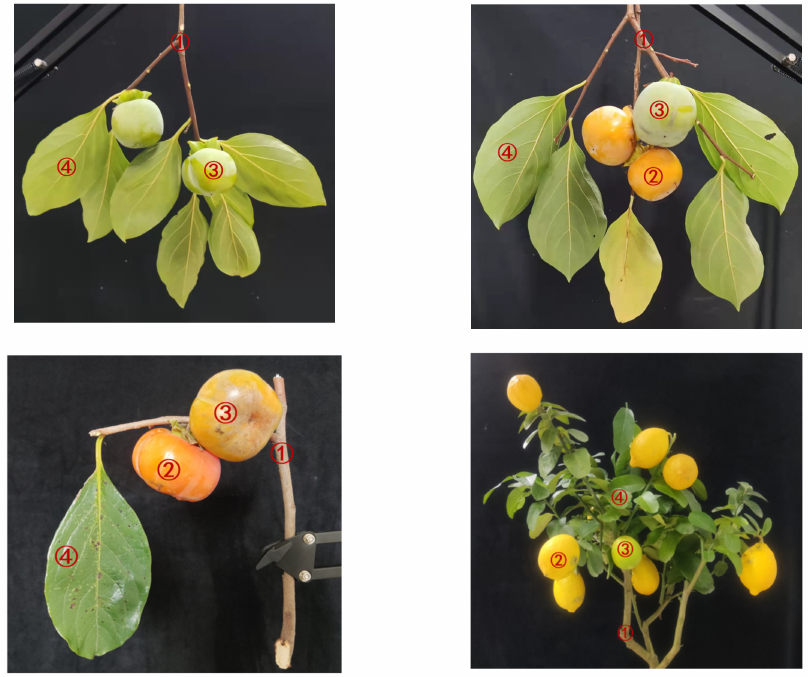
Figure 2. Fruit tree samples. 1 (cid:13) , 2 (cid:13) , 3 (cid:13) , and 4 (cid:13) correspond to the components of the wood, ripe fruit, unripe fruit, and leaves, respectively.